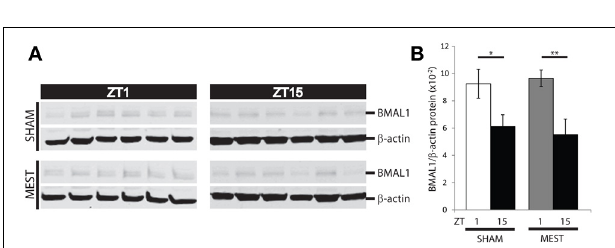
FIGURE 7 | Diurnal hippocampal BMAL1 expression is not affected by MEST. Time-of-day variation in BMAL1 hippocampal protein expression is unaffected by MEST. (A) Western blot of WT mouse hippocampal BMAL1 and b-actin in SHAM controls vs. MEST at ZT1 and ZT15. (B) Quantification of BMAL/b-actin protein expression from western blots in (A) ; t -test (two-tail) SHAM: ZT1 vs. ZT15 ∗ p < 0 . 05; MEST: ZT1 vs. ZT15 ∗∗ p < 0 . 01. N = 6 per group. Error bars = s.e.m. ZT, zeitgeber